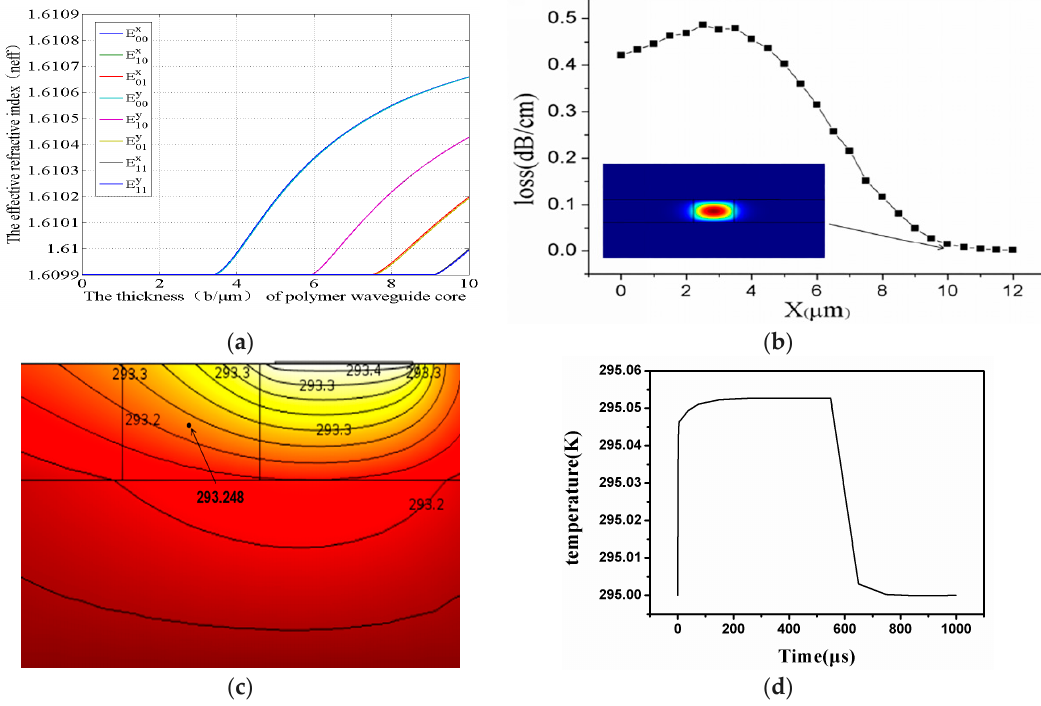
Figure 6. ( a )The single mode condition of UV-writing waveguide; ( b ) The optical field and the absorption of the electrode. ( c ) The thermal field with side electrode and graphene conduction layer; and, ( d ) The switching properties of the UV-writing polymer optical switch.